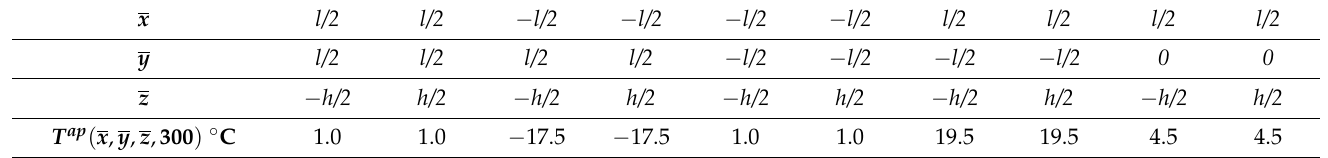
Table 3. Temperatures in the corners of the copper plate and at the midpoint of the plate’s surface facing the heated air inlet to the room for T c = − 19 ◦ C, v a = 0.5 m/s, and t = 300 s.